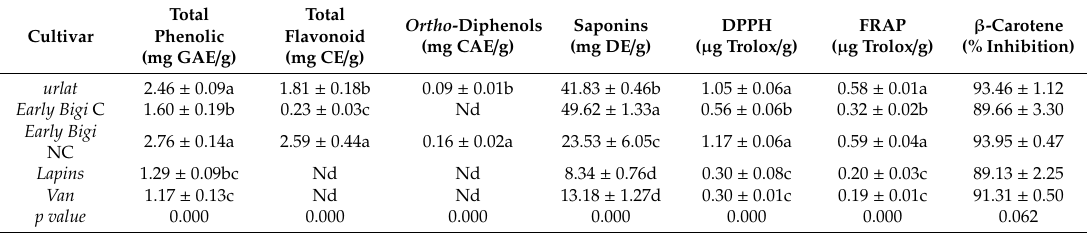
Table 2. Bioactive content and antioxidant activity of sweet cherry kernels from four di ff erent cultivars.